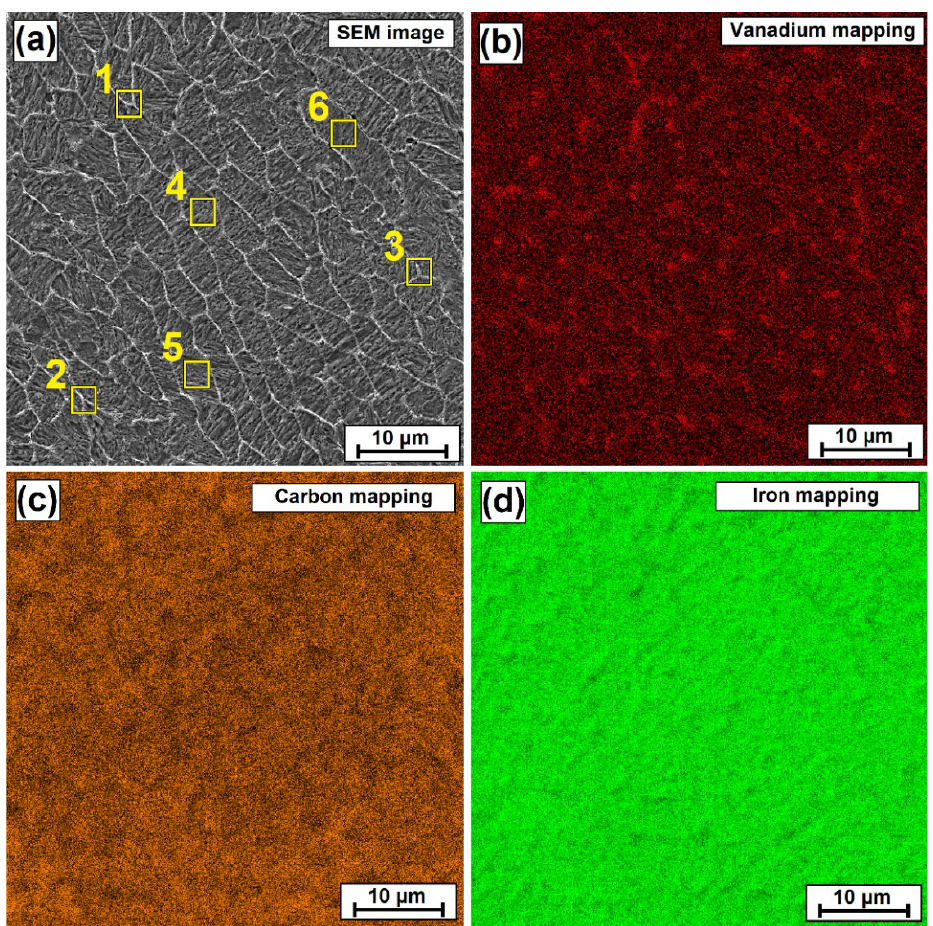
Figure 4. Vanadium coating produced using a laser beam power of 900 W: ( a ) SEM image with a marked analysis area, ( b ) vanadium mapping on the middle area of the coating, ( c ) carbon mapping on the middle area of the coating, ( d ) iron mapping on the middle area of the coating.